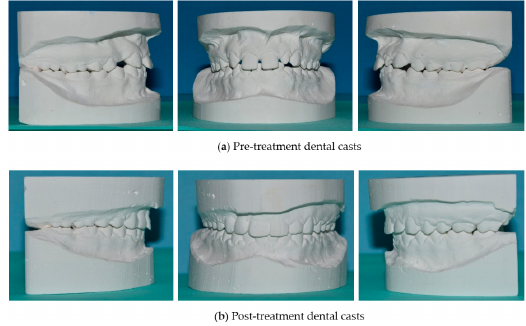
Figure 11. Pre-treatment and post-treatment dental